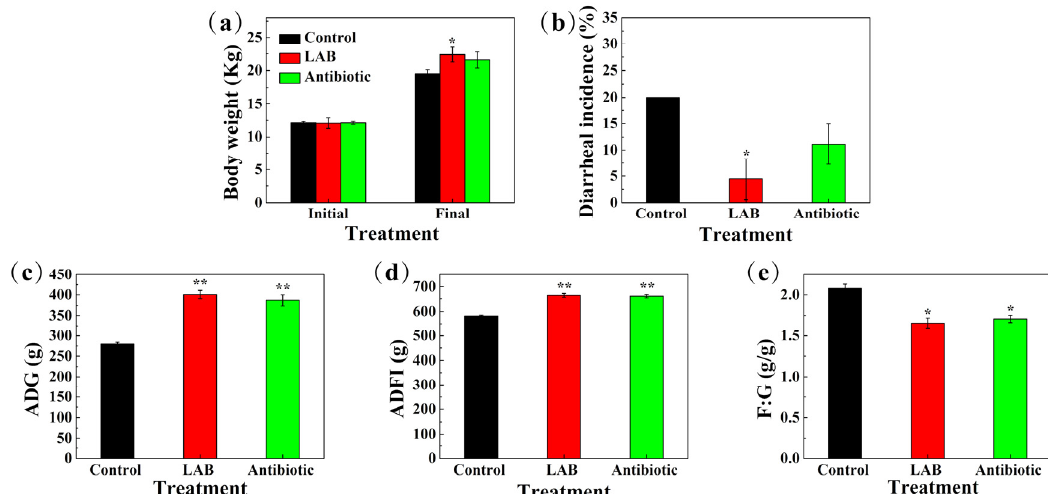
Figure 5. Effects of selected LAB strains and antibiotic on growth performance in weaned piglets. Control group, basal diet ( N = 30); LAB group, basal diet + 6% mixed selected LAB strains (N = 30); antibiotic group, basal diet + 150 mg/kg of aureomycin ( N = 30). ( a ) Body weight (Kg), ( b ) diarrheal incidence (%), ( c ) ADG (g), ( d ) ADFI (g) and ( e ) F:G (g/g). ADG, average daily gain; ADFI, average daily feed intake; F:G, feed:gain ratio. Asterisks denote significant differences compared with the control group (* p < 0.05, ** p <